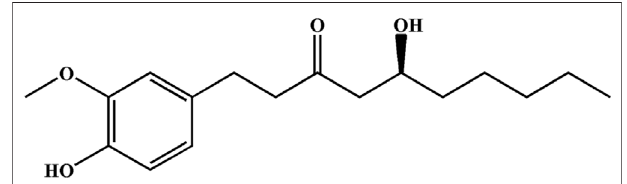
FIGURE 1 | Chemical structure of 6G.